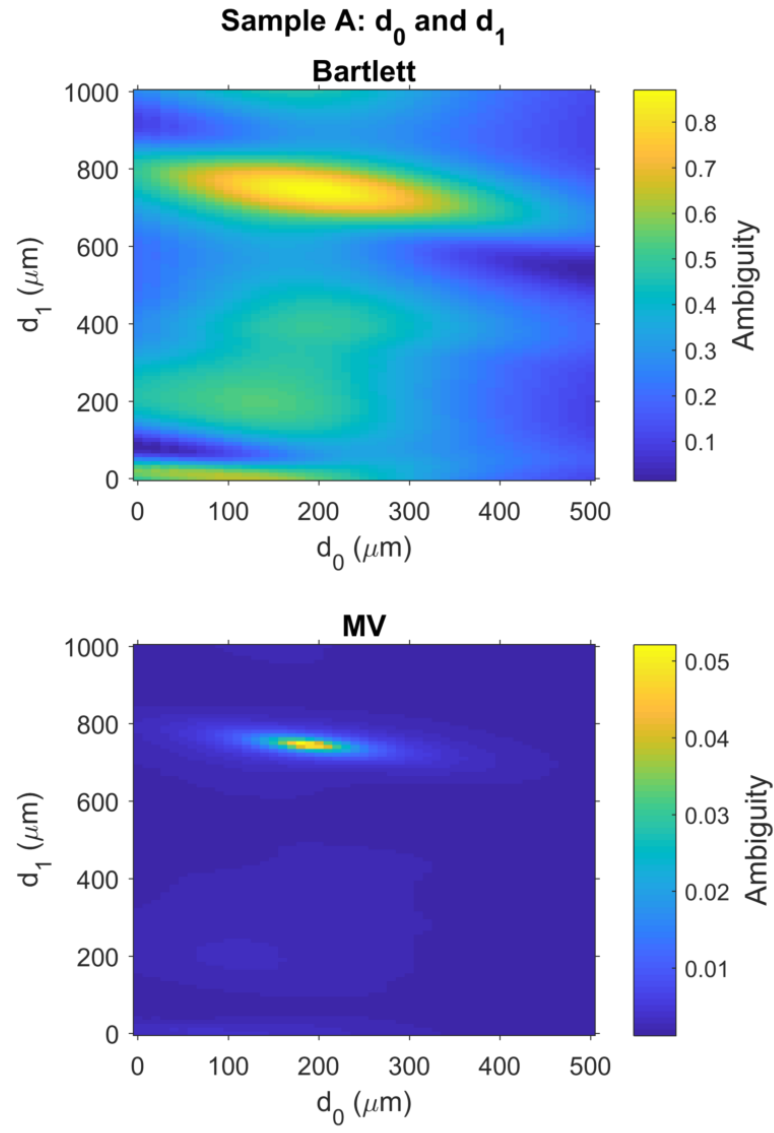
Figure 4. Matched field ambiguity surfaces provide estimates for the thickness of the calibration layer, d 0 , and polycarbonate layer, d 1 , as illustrated in Figure 1 with layer thickness for Sample A given in Table 1. ( Top ) Bartlett processor has a global maximum d 0 = 190 µ m and d 1 = 750 µ m; ( Bottom ) MV processor has a global maximum d 0 = 180 µ m and d 1 = 750 µ m. The results for d 1 are consistent with ground truth measurements with a Vernier caliper. Ground truth data are not available for the calibration layer, but the these results are reasonable, and consistent between both Bartlett and MV processors. See Table 2 for a comparison of measurement errors for layers in all